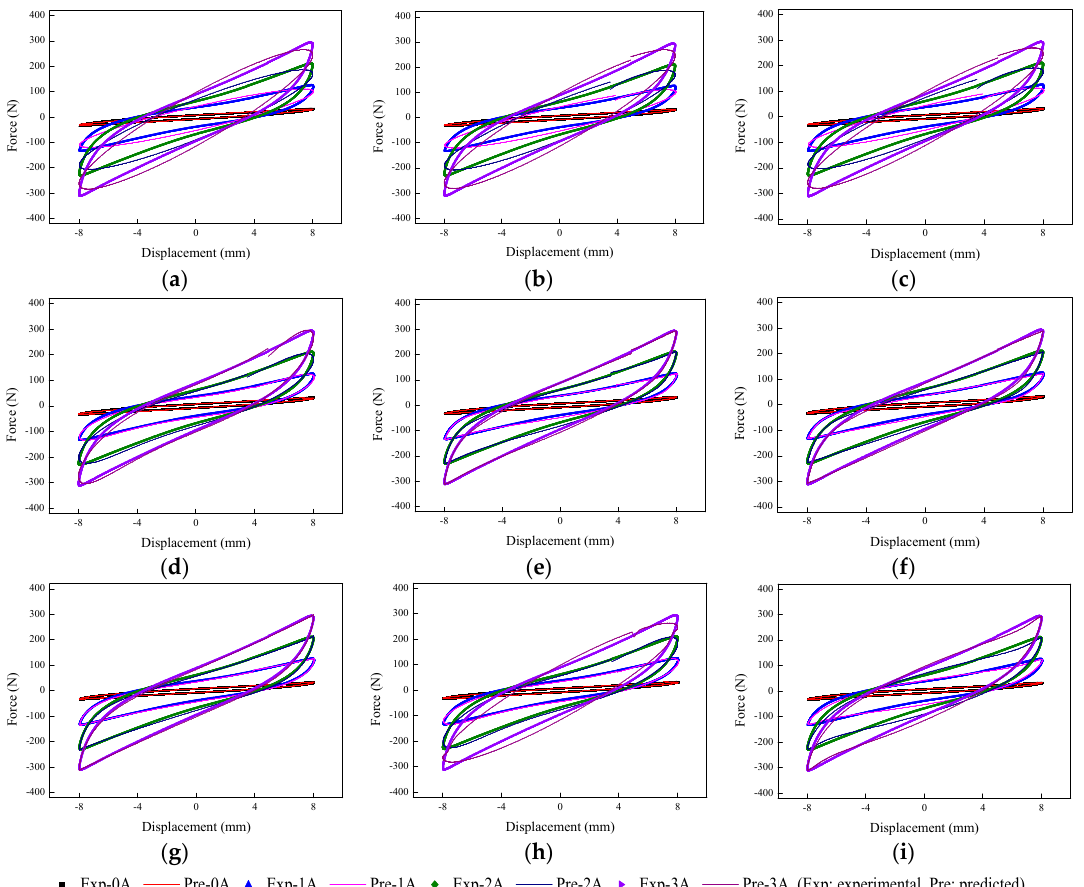
Figure 17. Comparisons of force–displacement responses between experimental results and model predictions when the loading frequency and amplitude are 0.1 Hz and 8 mm. ( a ) Kelvin–Voigt model, ( b ) four-parameter viscoelastic model, ( c ) rheological model, ( d ) BW model, ( e ) improved BW model, ( f ) Dahl model, ( g ) improved LuGre friction model, ( h ) strain stiffening model, and ( i ) hyperbolic hysteresis model.